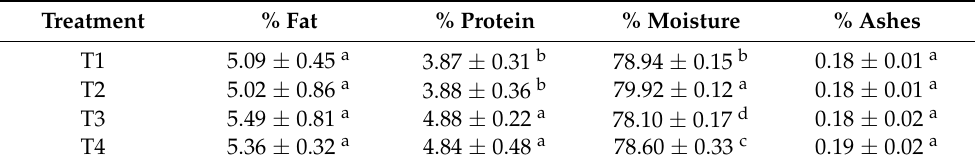
Table 1. Physicochemical analysis of yogurt added with beet extracts ( Beta vulgaris sp.).